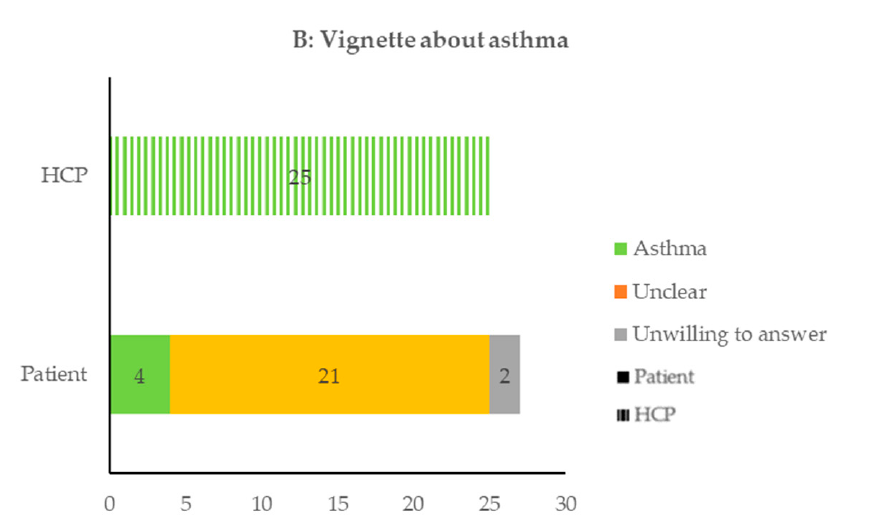
Figure 1. Identification of the chronic obstructive pulmonary disease (COPD) and asthma vignette from patients and healthcare professionals (HCPs).